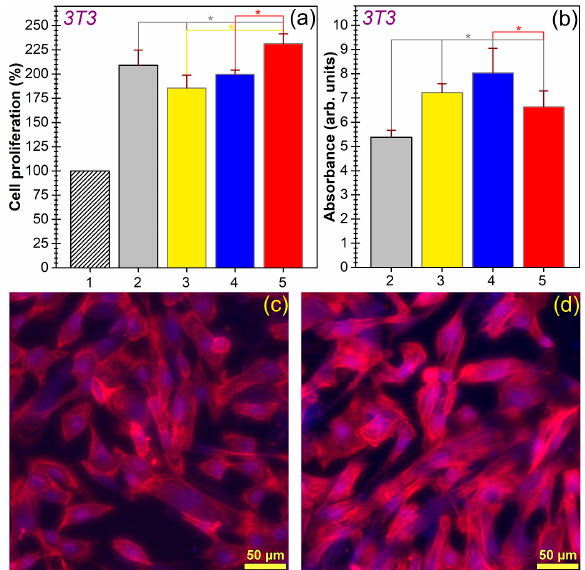
Figure 9. ( a ) Cell viability/proliferation assessed by MTS assay and ( b ) cytotoxicity assessed by LDH release after 24 h. (1) seeded cells; (2) biological control—polycarbonate; (3) bare and silica-rich (4) FastOs ® BG and (5) Cu&Ga-FastOs ® BG coated substrate. * p < 0.05, statistically significant differences, as determined by using an unpaired two-tailed Student’s t -test. Epi-fluorescence microscopy images revealing the morphology of 3T3 fibroblast cells grown on the silica-rich: ( c ) FastOs ® BG and ( d ) Cu&Ga-FastOs ® BG films. The actin cytoskeleton was stained with phalloidin-AlexaFluor596 (red), whilst cell nuclei were counterstained with DAPI (blue). Objective: 40 × . Magnification bar: 50 µ